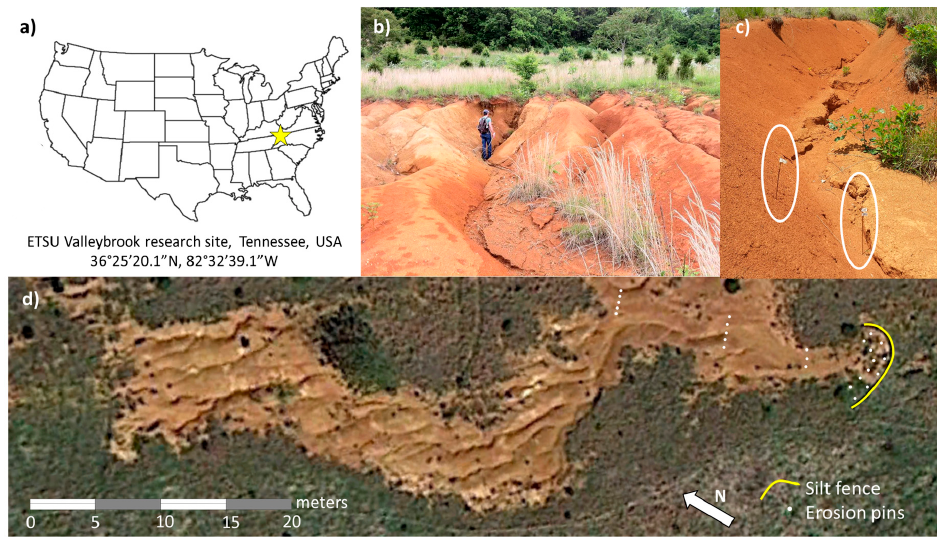
Figure 1. Gully system location and setting (modified after Luffman et al. (2015)). ( a ) Geographic location of study area; ( b ) a typical gully in the system; ( c ) erosion pins (circled) are 0.5–1 m long, with exposed length approximately 30 cm in this image; ( d ) aerial view of the studied gully, silt fence is outlined in yellow and pins in delta and gully area are marked with white circles. Aerial image from Google Earth (2012 imagery).